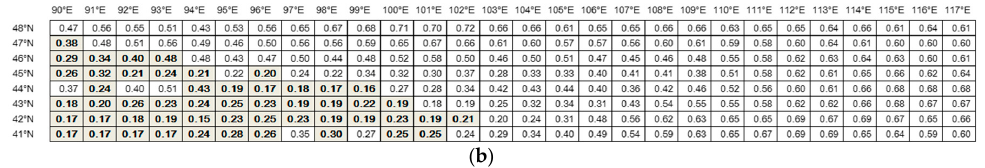
Figure 5. ( a ) Map of the correlation between precipitation and NDVI, and distribution of time lag in response to precipitation; ( b ) Correlation coefficient matrix. Each bold number shows that the correlation coefficient has some time lag.